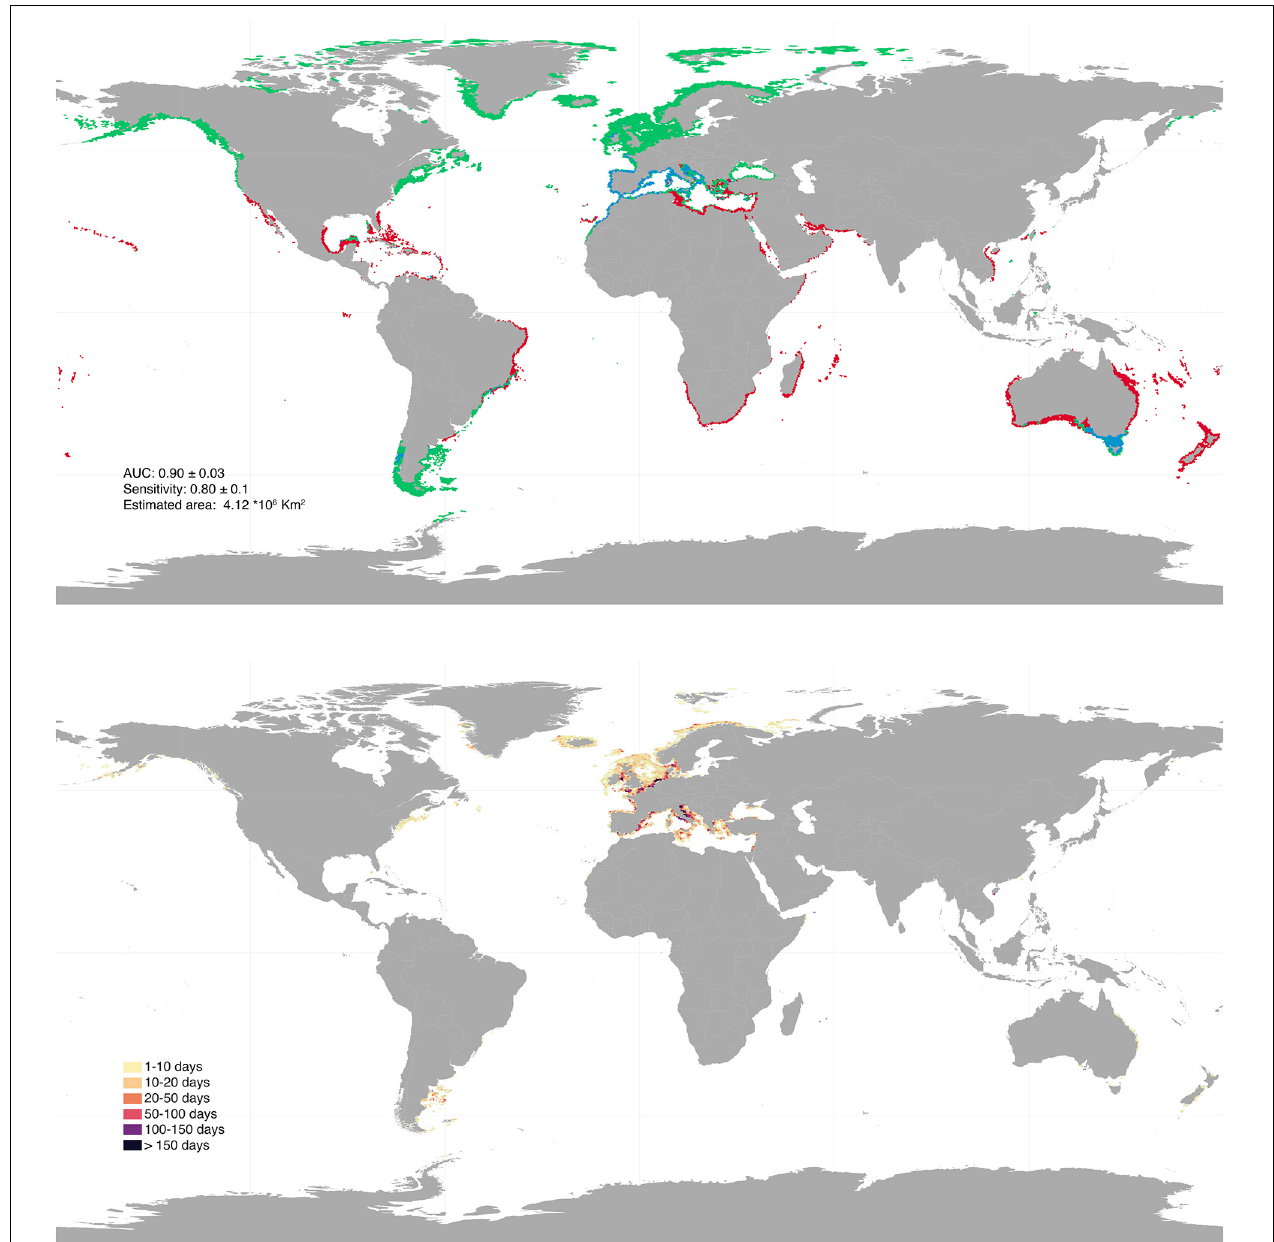
FIGURE 2 | Upper panel: global present-day rhodolith distribution as inferred for polar—cold temperate (green) and tropical—warm temperate affiliated species (red). Regions of overlap are depicted in blue. Bottom panel: bottom trawling intensity (days per year) overlaying rhodolith suitable habitats for present day distribution. Results were aggregated for better visualization. High resolution maps can be found in Supplementary Material